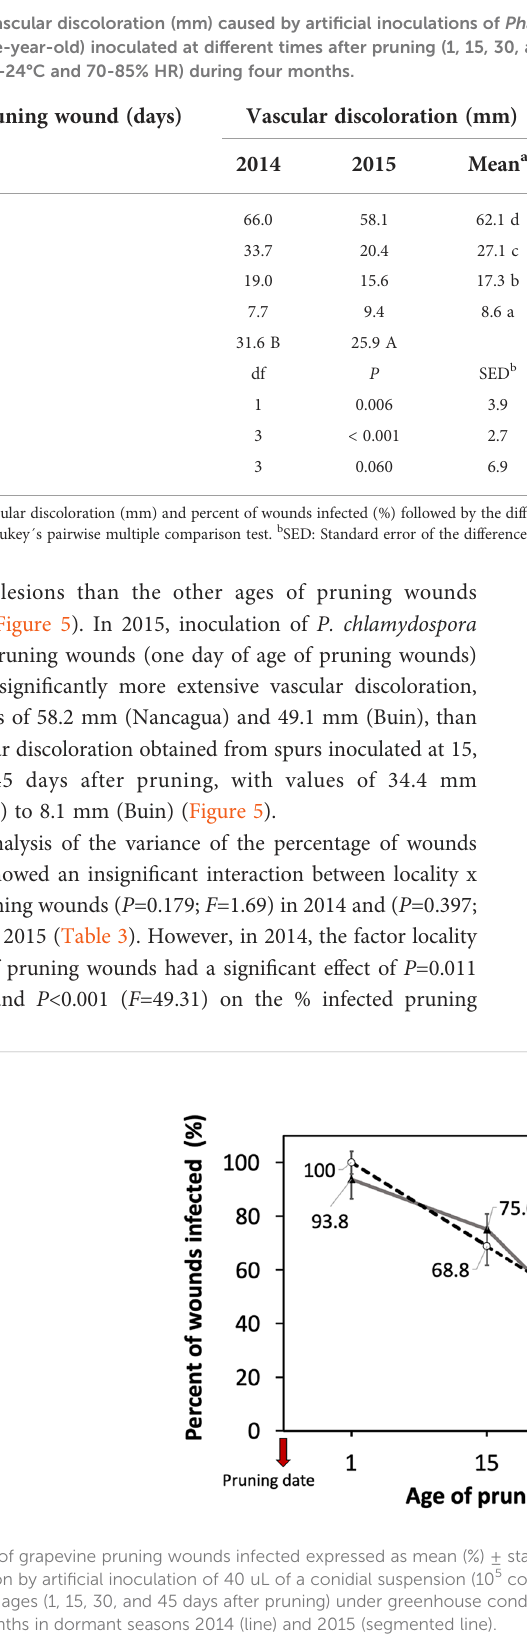
TABLE 1 Vascular discoloration (mm) caused by arti fi cial inoculations of Phaeomoniella chlamydospora (Pach-3) on pruning wound of rooted cutting (one-year-old) inoculated at different times after pruning (1, 15, 30, and 45 days), under greenhouse conditions (with temperature between 15-24°C and 70-85% HR) during four months.